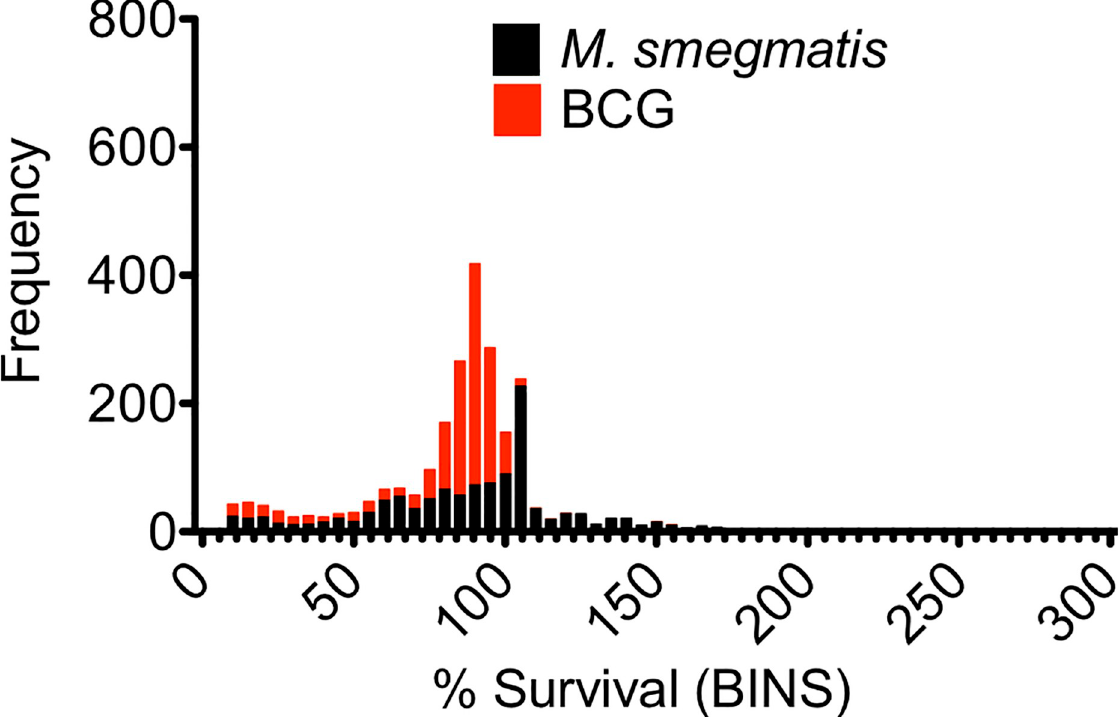
Fig 3. A comparative frequency distribution of the primary screening against the Prestwick Chemical Library. Each bar represents the comparative frequency distribution primary screening data (averaged) for M . smegmatis (black) and BCG (red). % survival data for was ‘binned’ into groups of